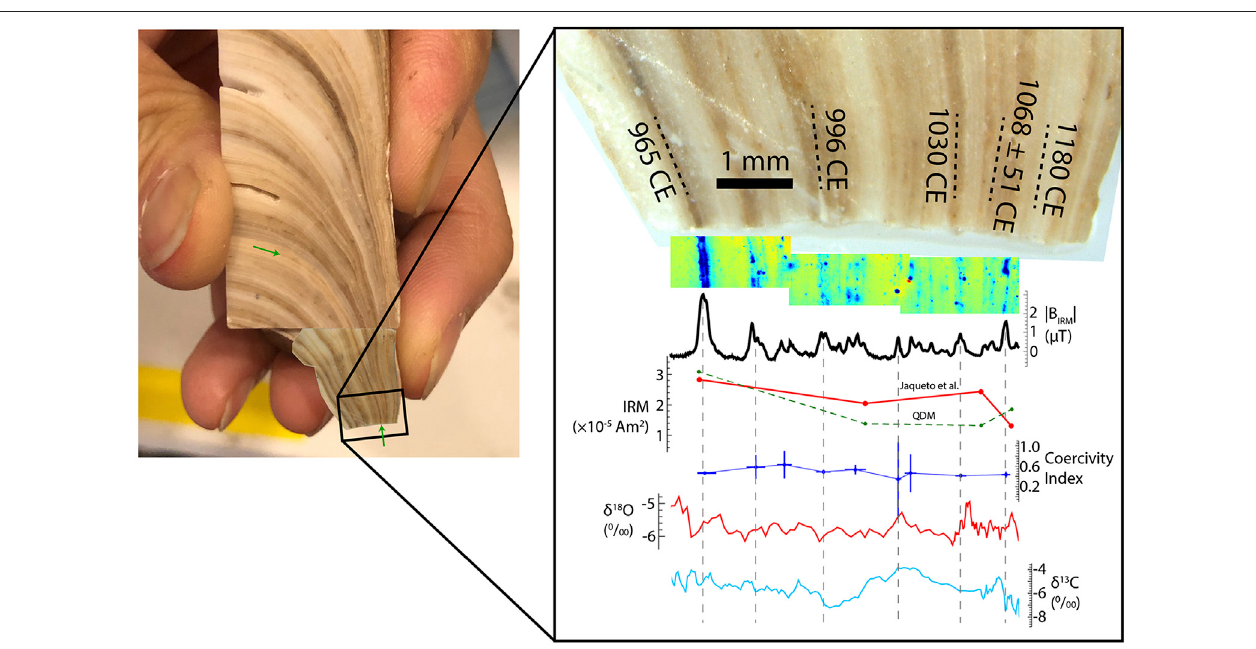
FIGURE 2 | Photographs of the measured sections of the ALHO6 speleothem with age dates, magnetic fi eld time series, and δ 18 O and δ 13 C data. Age tie point of 1068 CE is based on U-Th dating of laminae while other tie points are interpolated from other U-Th ages based on distances in the speleothem central column. In right panel, fi rst overlay shows the magnetic fi eld map corresponding to a 1.5 T IRM oriented into the mapping plane. B IRM curve is a time series of mean magnetic fi eld intensity computed from the map above. Red and green IRM curves are the bulk samples of Jaqueto et al. (2016) and QDM magnetic fi eld values binned to the same time intervals. Coercivity Index curve is computed for each magnetized band and approximates the fraction of total magnetization with coercivity between 17 and 70 mT.Verticalerror barsare2 σ .Oxygenand carbon isotopic dataarefromNovelloet al.(2016). Intheleftpanel, greenarrows highlightexampleofalamina thatshows much stronger coloration in the speleothem fl ank, although most laminae show greater continuity.